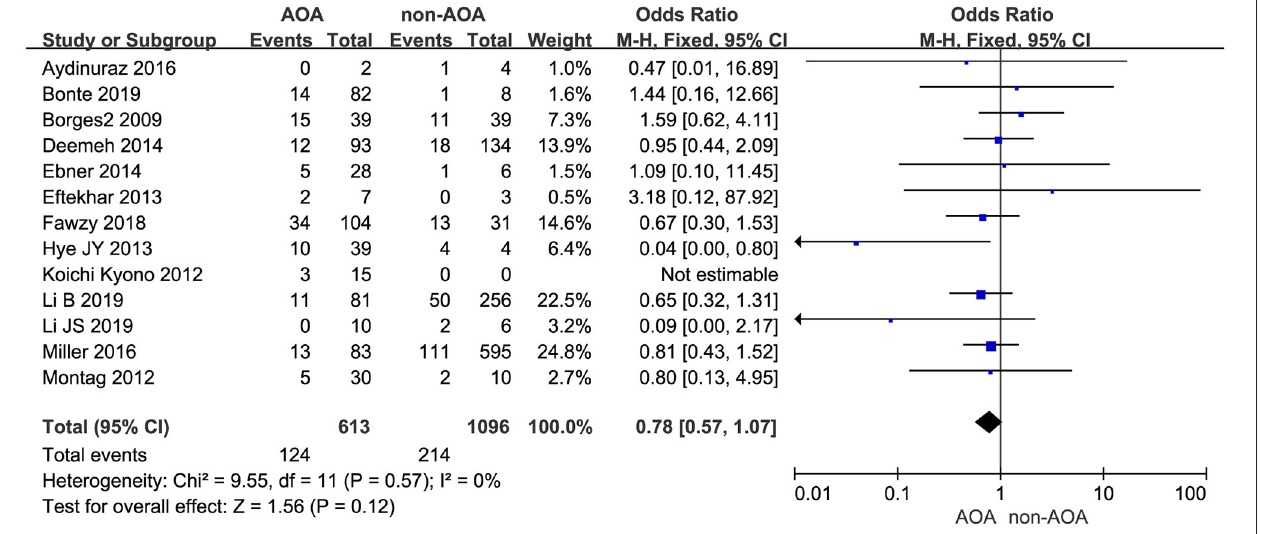
FIGURE 9 | Forest plot of miscarriage rate between AOA treatment and non-AOA treatment patient groups using calcium